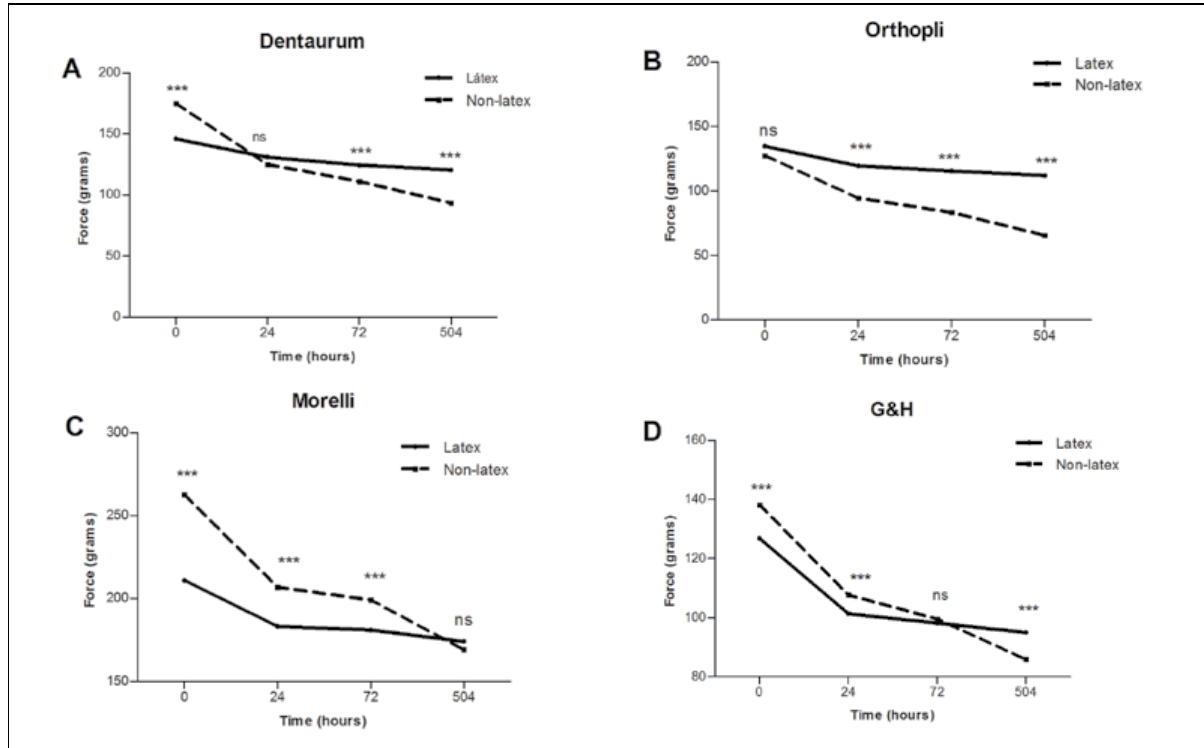
Figure 1. Comparison between the means of forces of the elastic latex and non-latex: Dentaurum, Orthopli, Morelli and G&H, in all experimental periods. *** p < 0.001; ns = not significant.